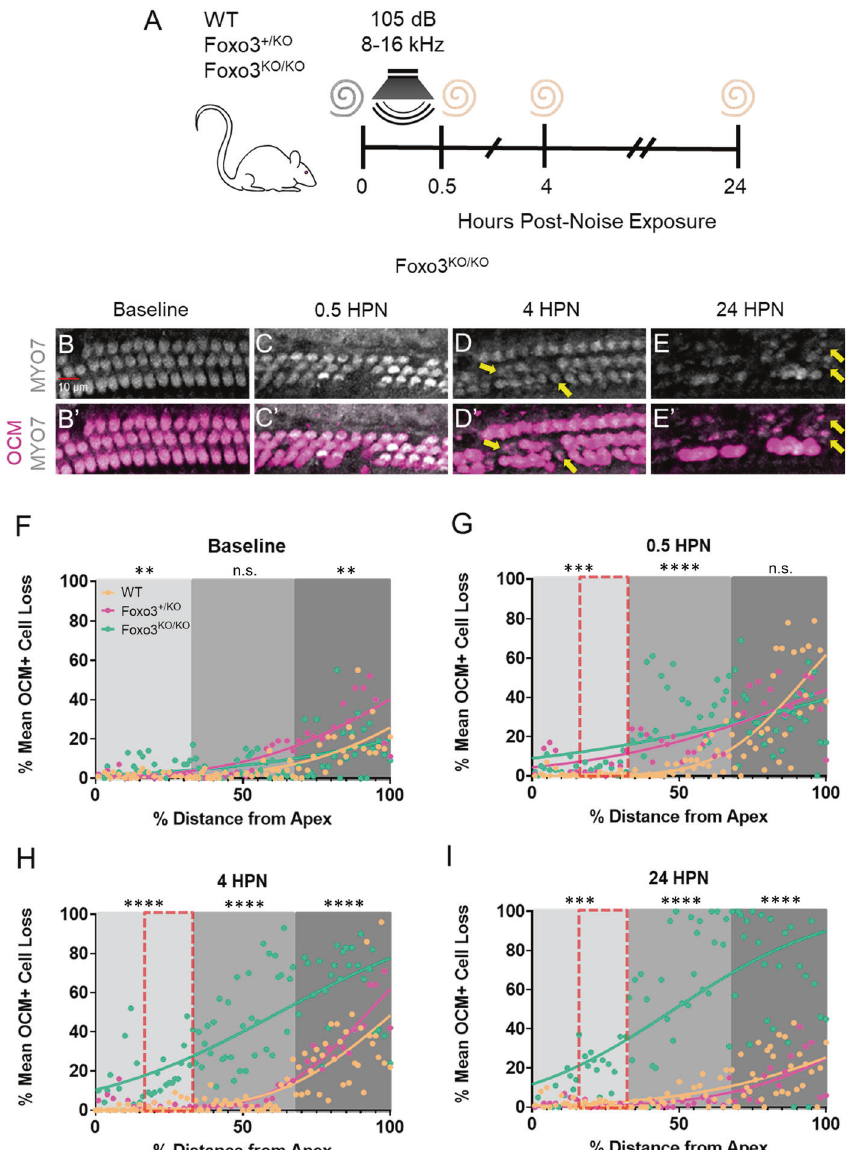
Fig. 1 OCM modulation observed immediately following noise exposure. A Noise exposure method for WT, Foxo3 + / − , and Foxo3 − / − mice. Cochleae were extracted for whole-mount immunohistochemistry immediately following the exposure (0.5 h post-noise exposure or HPN), at 4 HPN, or 24 HPN. Unexposed littermates served as baseline controls. B – E Expression of MYO7 (white) was maintained in the Foxo3 − / − OHCs following noise exposure (yellow arrows). B ′ – E ′ Over the same time course, OCM (pink) immunoreactivity decreased in OHCs, mainly in rows 2 and 3. n = 3, scale bar = 10 µm, ×20 magni fi cation, ~24 kHz region. F – I Cochleograms of % mean OCM + cell loss ( y -axis) plotted against % distance from the cochlear apex ( x -axis). Each dot represents the mean number of OCM + cells counted in 100 µM intervals along the length of cochleae (4 – 86 kHz) pooled ( n = 3 – 6 per genotype/condition). Cochlear tonotopic regions are presented by background color: Apex = light gray, Middle = gray, Base = dark gray. Non-parametric interpolation lines are presented for each group: WT (orange), Foxo3 + / − (pink), and Foxo3 − / − (green). G – I The noise band is presented as a red dotted outline. Kruskal – Wallis rank-sum test adjusted for multiple comparisons, alpha = 0.05, * p < 0.05, ** p < 0.01, *** p < 0.001, **** p <